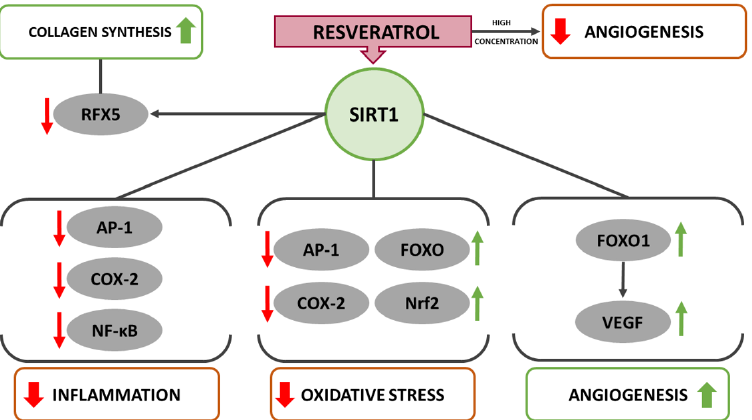
Figure 1. Schematic diagram of the potential role of resveratrol-induced SIRT1 activation in suppressing inflammation as well as oxidative stress and promoting angiogenesis in wound healing.